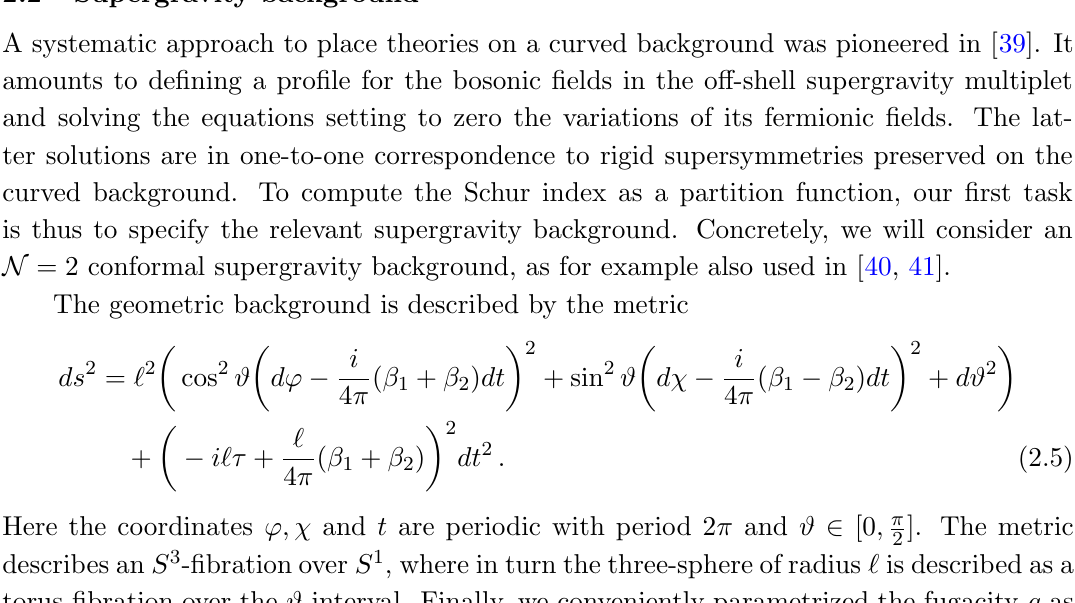
Figure 1 clari(cid:12)es the de(cid:12)nition of the coordinates. The background also turns on a